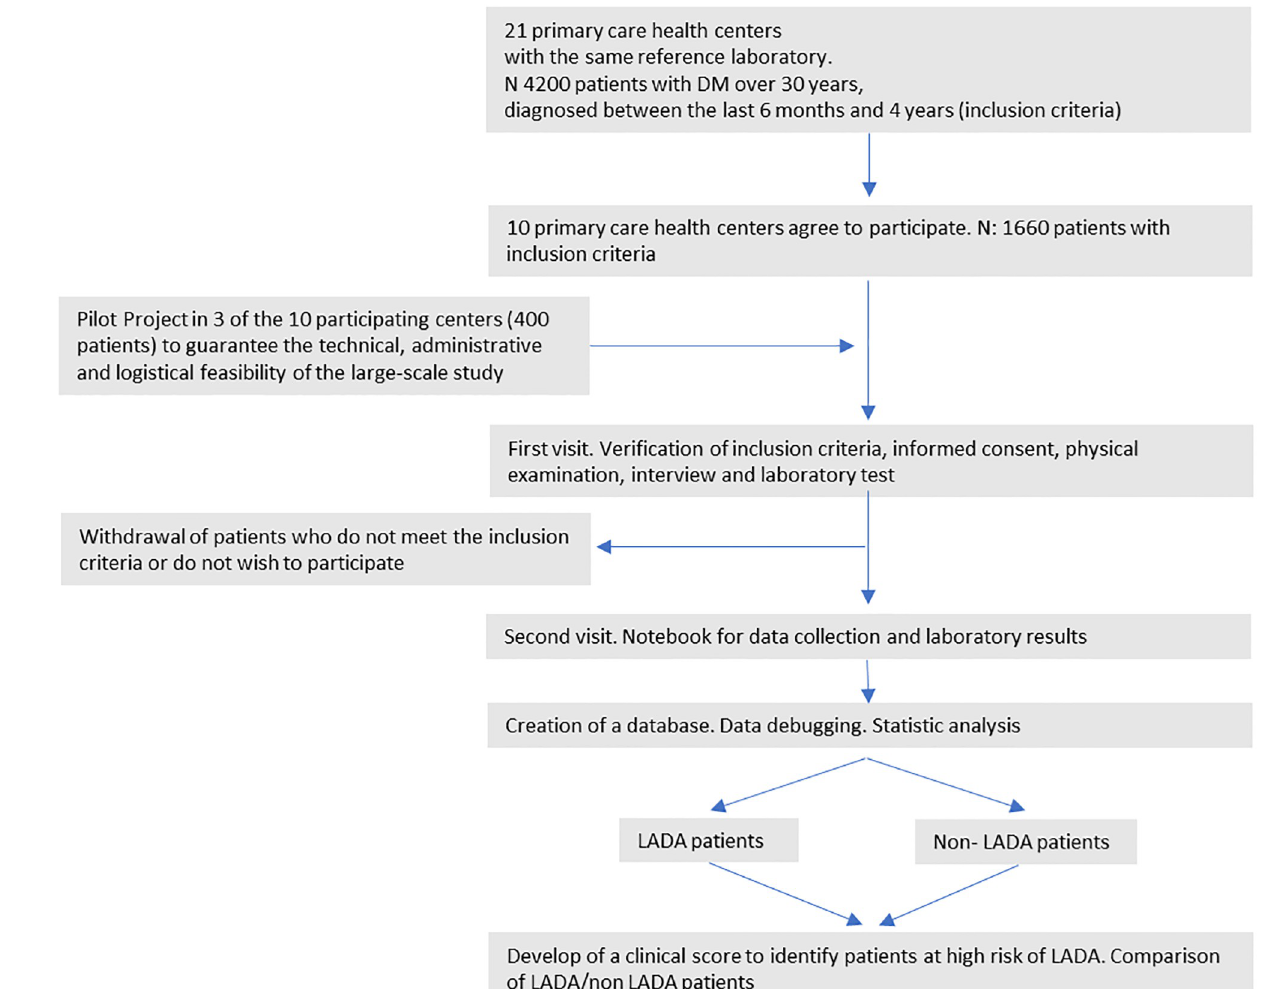
Fig 1. Flow chart of the LADA primary care protocol study. (mg/dl), HDL cholesterol (mg/dl), LDL cholesterol (mg/dl), Triglycerides (mg/dl), Anti GAD 65 antibodies: (+/- and titer -IU/mL-), Anti-peroxidase antibodies: (+/- and titer-IU/mL-), Antithyroglobulin antibodies: (+/- and titer-IU/mL-). Treatment for diabetes mellitus (S16 Table): lifestyle performances, Metformin, Sulfonyl- ureas, Dipeptydil-peptidase-4 inhibitors, Pioglitazone, Repaglinide, SGLT-2 inhibitors, GLP-1 analogs, Insulin. Other treatments (S17 Table): angiotensin converting enzyme inhibitors (ACEI), angioten- sin receptor blockers (ARBs), Non-ACEI/ARBs antihypertensives, Lipid-lowering drugs, anxi- olytics and hypnotics drugs, antidepressants drugs, antipsychotics drugs, antiplatelet drugs, anticoagulant drugs, Analgesics, Anti-tumor drugs, Immunomodulator drugs, corticosteroids. Comorbidities (S18 Table): Microalbuminuria, Chronic Kidney Disease, Diabetic retinopa- thy, Diabetic neuropathy, arterial hypertension, hypercholesterolemia, hypertriglyceridemia, metabolic syndrome, ischemic heart disease, peripheral arterial disease, cerebrovascular dis- ease, atrial fibrillation, heart failure, COPD, asthma, mood disorder, psychotic disorder.